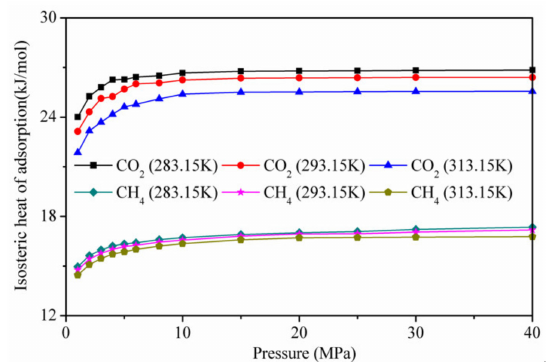
Figure 10. Isotherm adsorption heat of CO 2 and CH 4 on kaolinite at di ff erent temperatures.